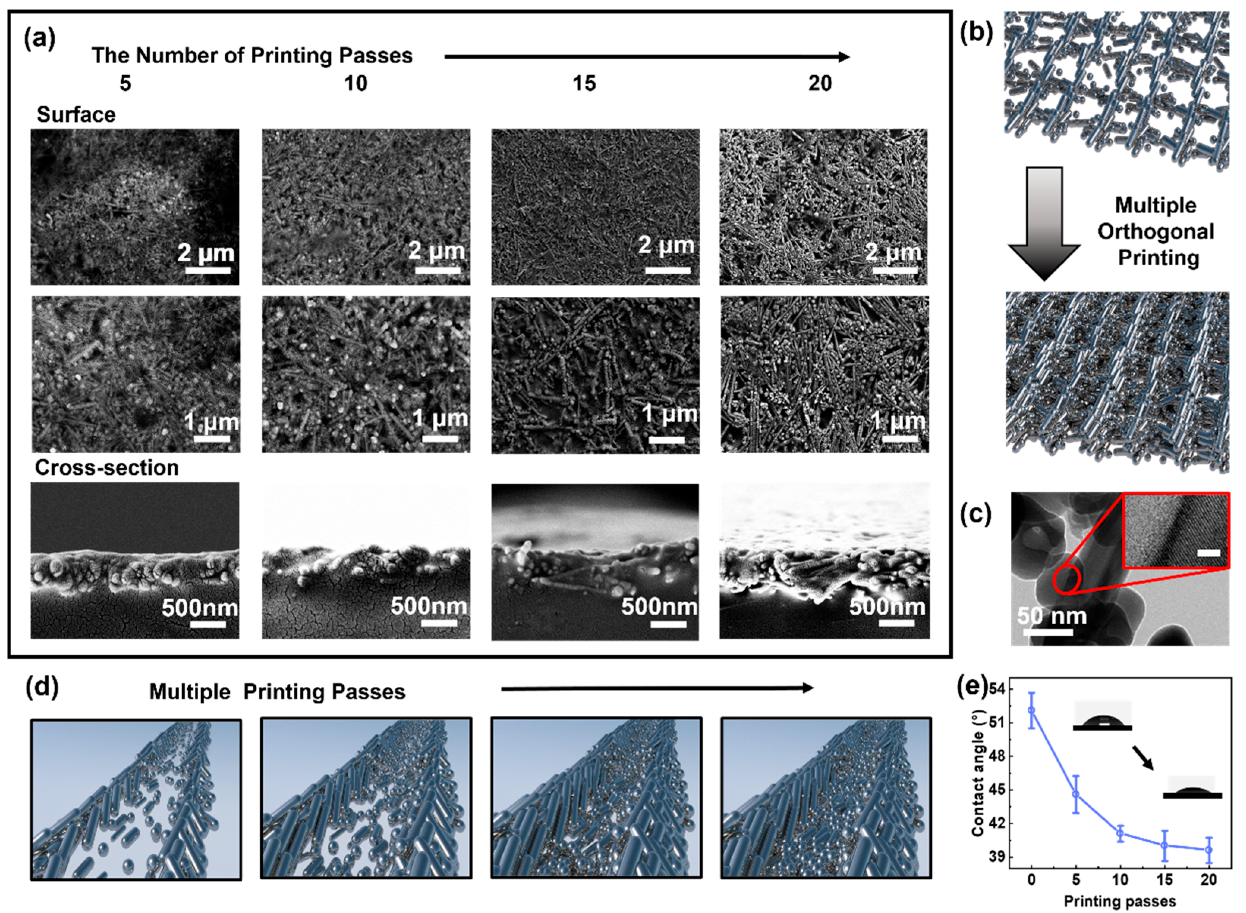
Figure 2. Morphology and microstructure of the structurally integrated 3D conductive networks of hybrid AgNRs/NPs. ( a ) SEM and cross-sectional SEM images of the elastomer-encased 3D networks with different print layers. ( b )The fabrication model of the 3D networks with orthogonal hybrid AgNRs/NPs arrays. ( c ) Transmission electron microscopy (TEM) image of the hybrid AgNRs/NPs showing continuous lattice fringes. Scale bar in the inset is 2 nm. ( d )The variation in contact angle of water on AJP-derived films with different print layers, showing changing deposition behaviors. ( e ) The ordered migration and assembly of hybrid AgNRs/NPs on pre-deposited Ag traces with increasing surface energy.